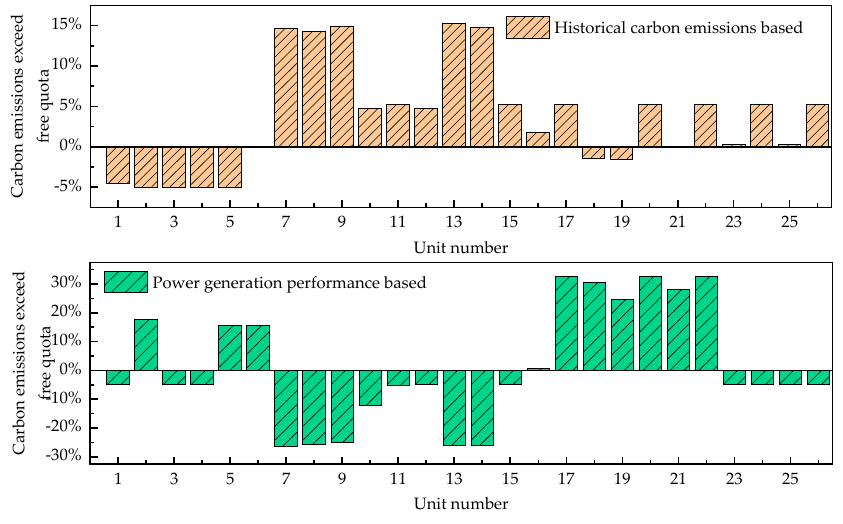
Figure 11. Comparison of carbon emissions of conventional units.